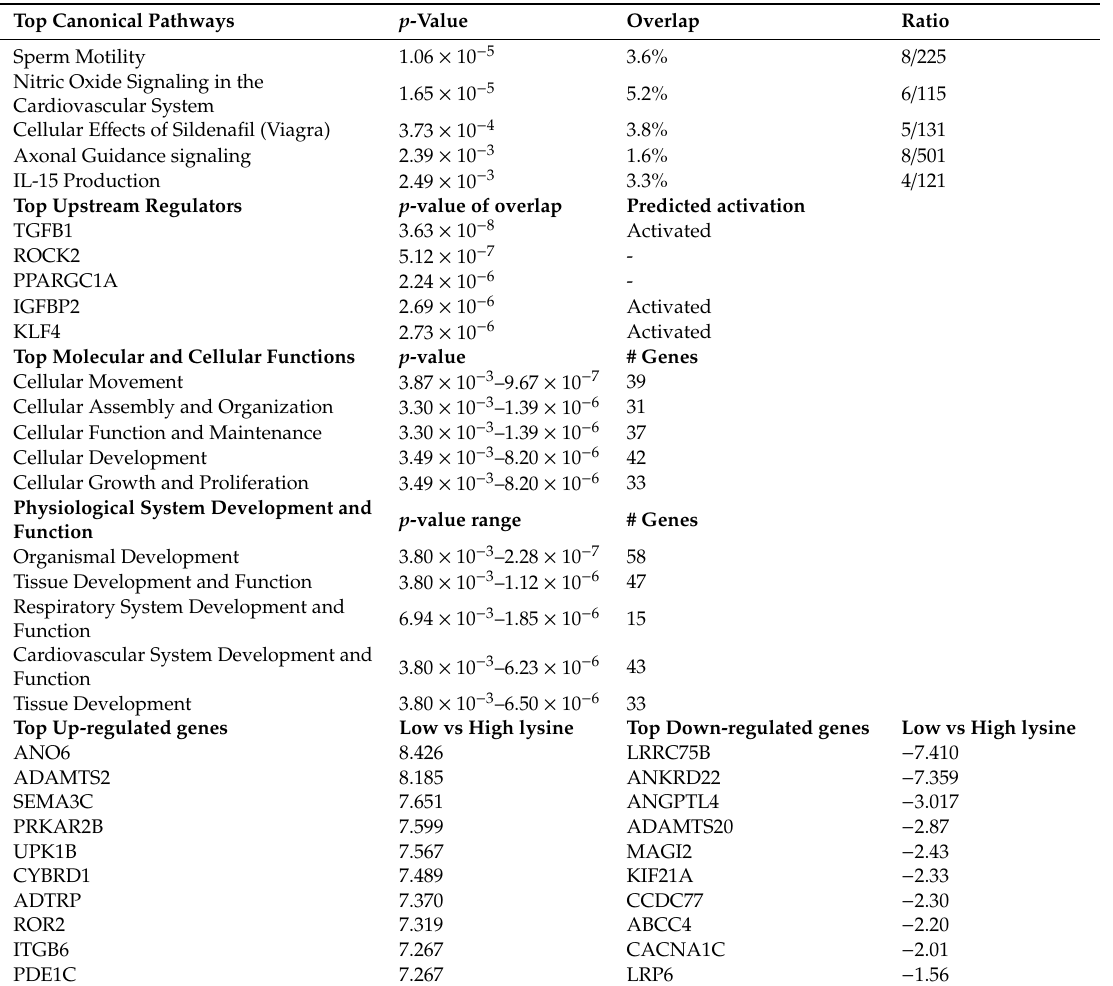
Table 4. IPA summary of liver transcriptomes in samples from broiler chickens fed diets containing high and low lysine